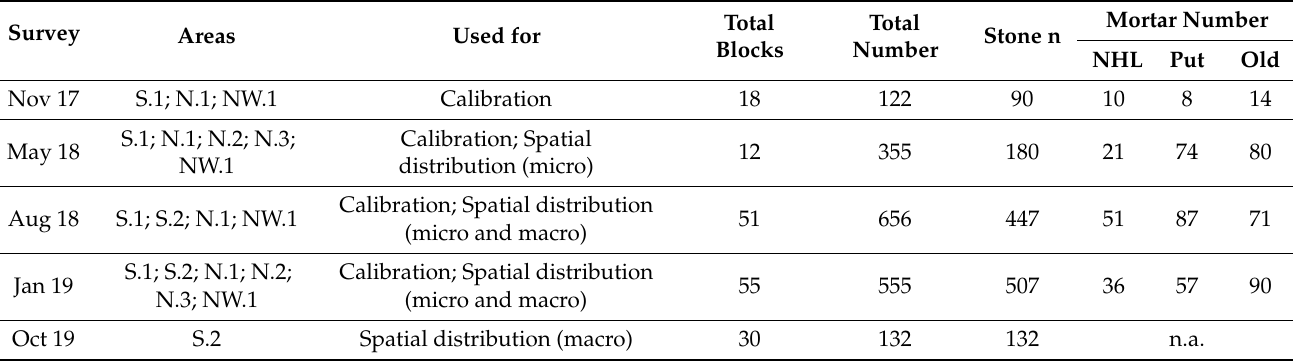
Table 2. Summary of moisture meter surveys, showing areas surveyed, types of analysis performed on data, and number of measurements made. Also includes distribution of measurements according to material